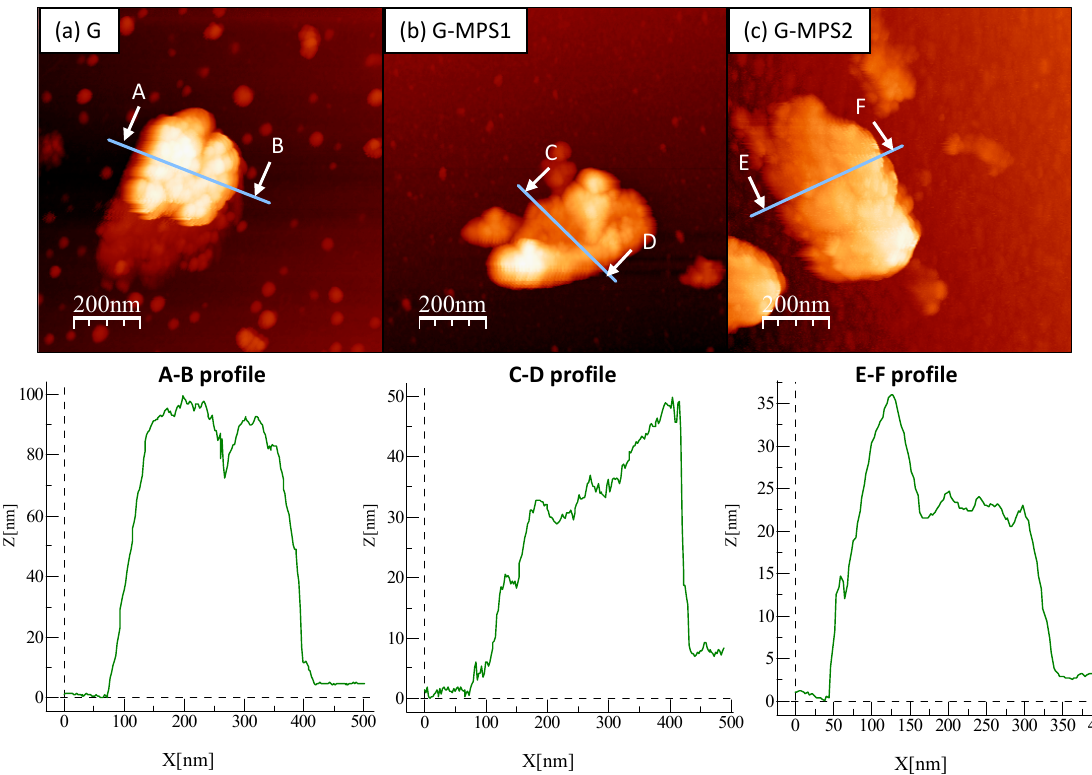
Figure 1. Topography atomic force microscopy (AFM) images of graphene (G) ( a ), silanised G obtained from G_Oxi1 (G_MPS1) ( b ) and from G_Oxi2 (G_MPS2) ( c ) powders deposited on mica discs, after dispersion on methyl methacrylate (MMA) liquid by ultrasonication. The bottom images correspond with the indicated z-profiles and show the thickness of the graphene clusters.